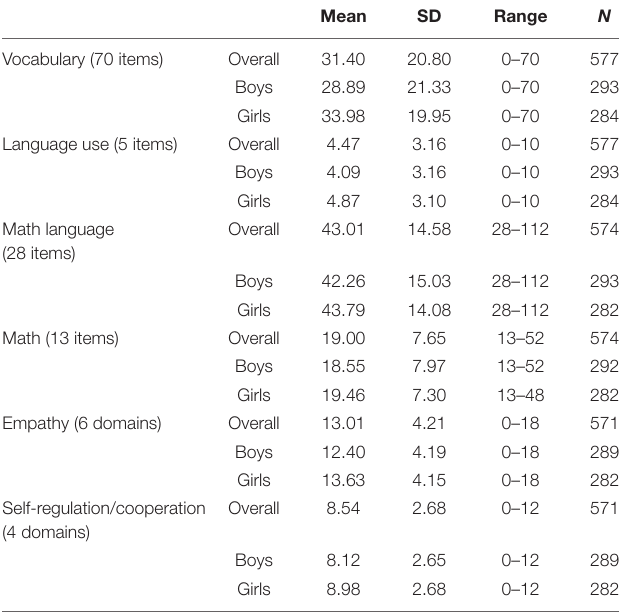
TABLE 1 | Descriptive information on children’s language, math, and socio-emotional skills at time 1.